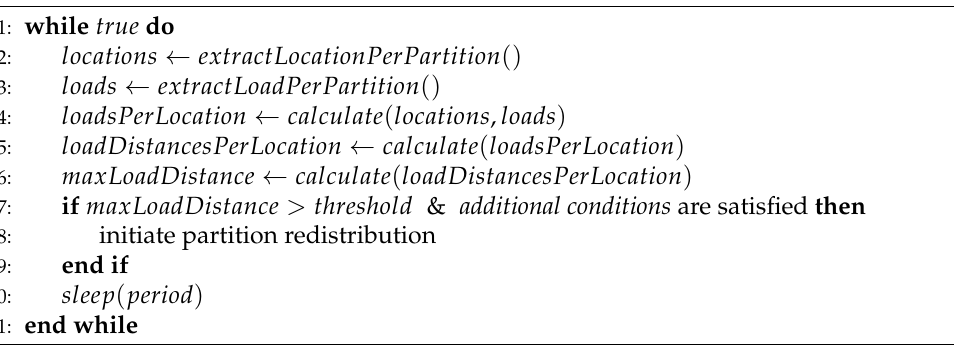
Algorithm 1 Algorithm of Dynamic